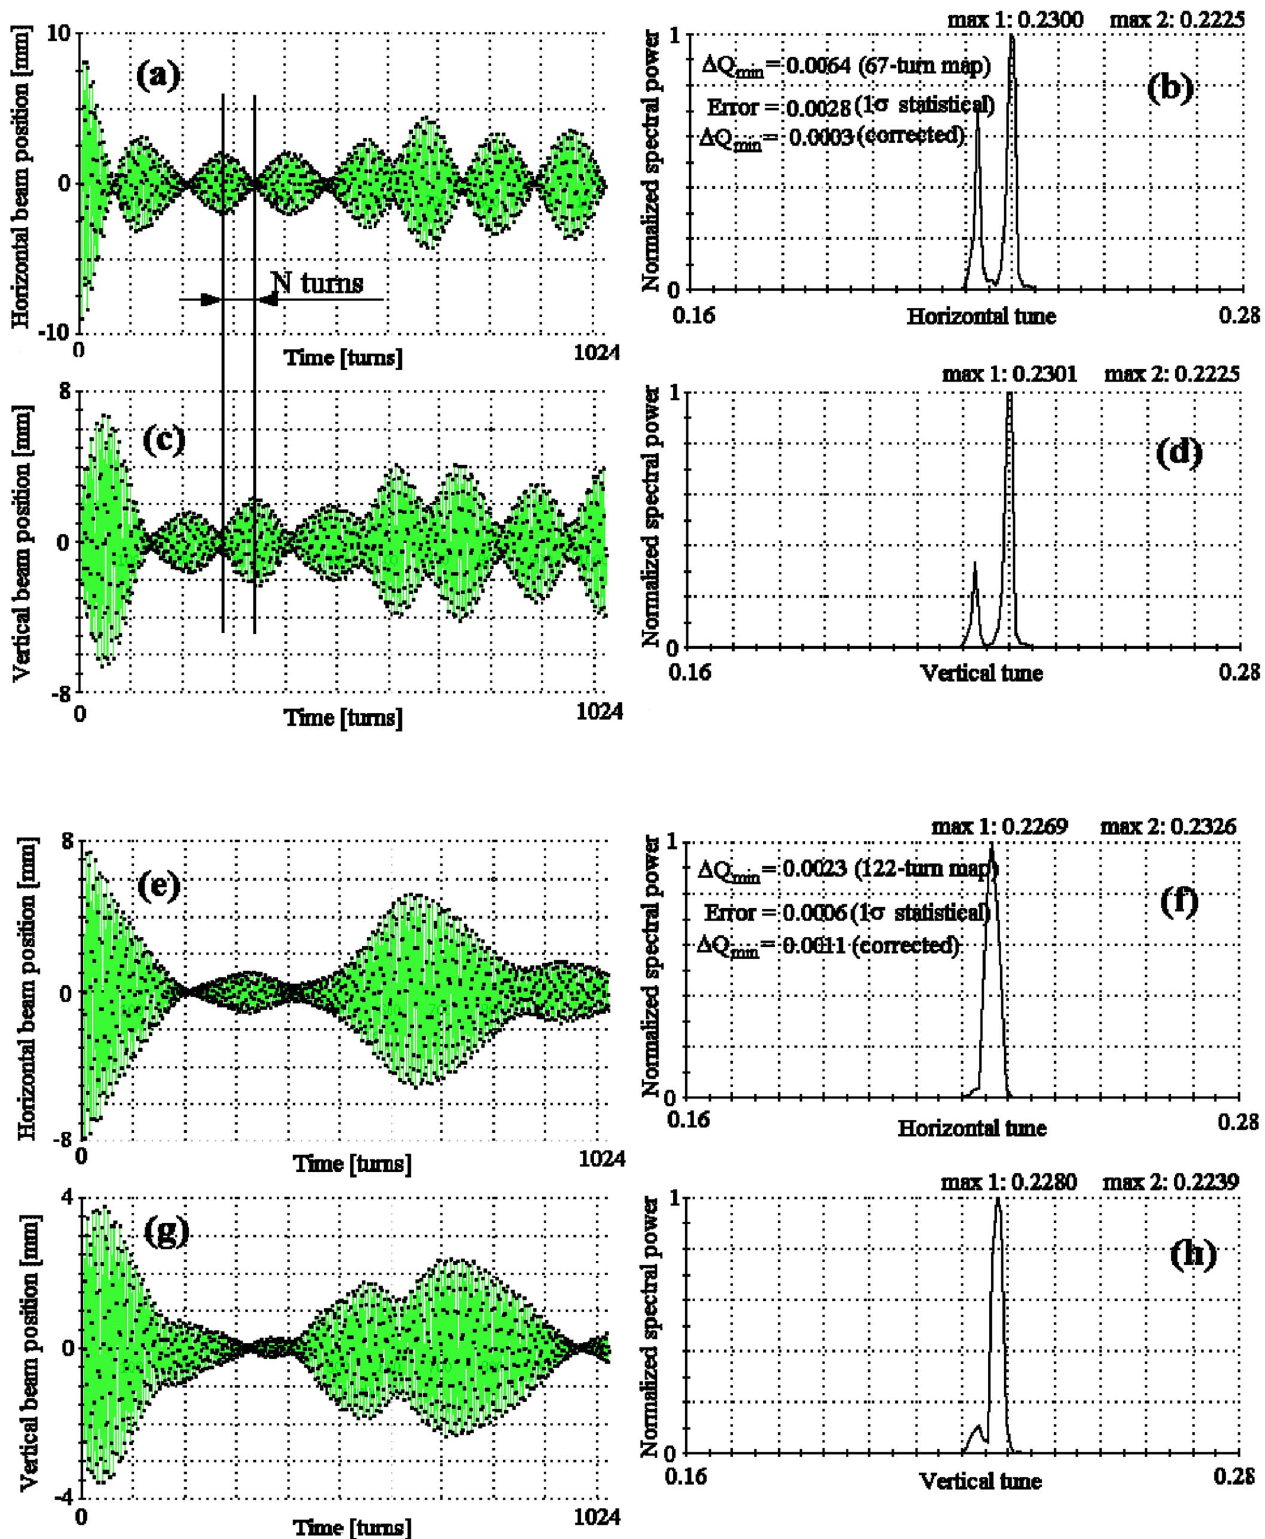
FIG. 2. (Color) Turn-by-turn signals and spectra before and after a coupling correction. In (a) and (c) the horizontal and vertical injection oscillations are shown before a coupling correction. In (b) and (d) the respective spectra are depicted. (b) also shows the , its error, and the predicted (cid:1) Q after a coupling correction. (e)–(h) show the situation after the computed computed (cid:1) Q min min corrector values were